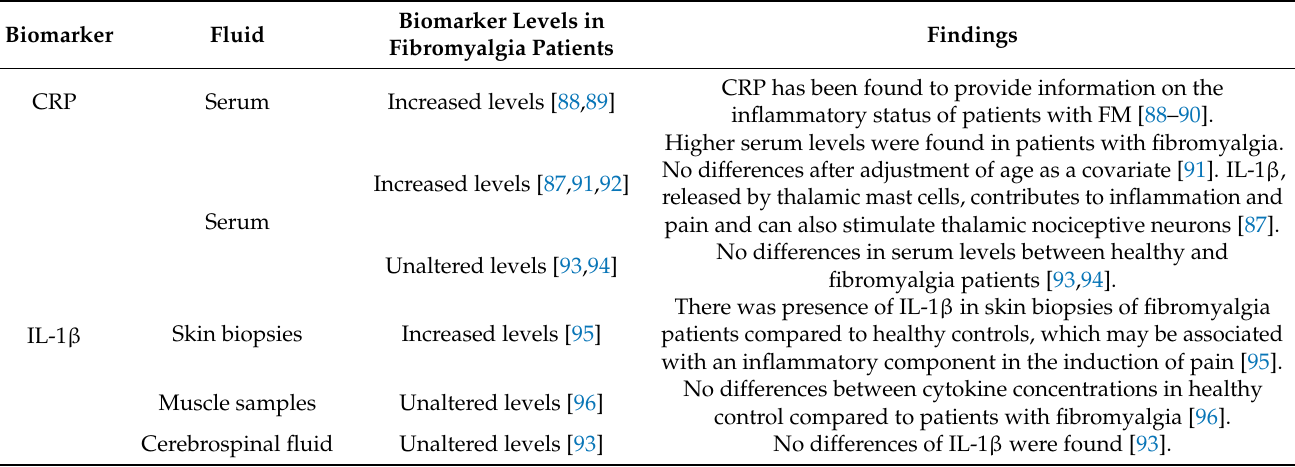
Table 2. Potential salivary biomarkers in